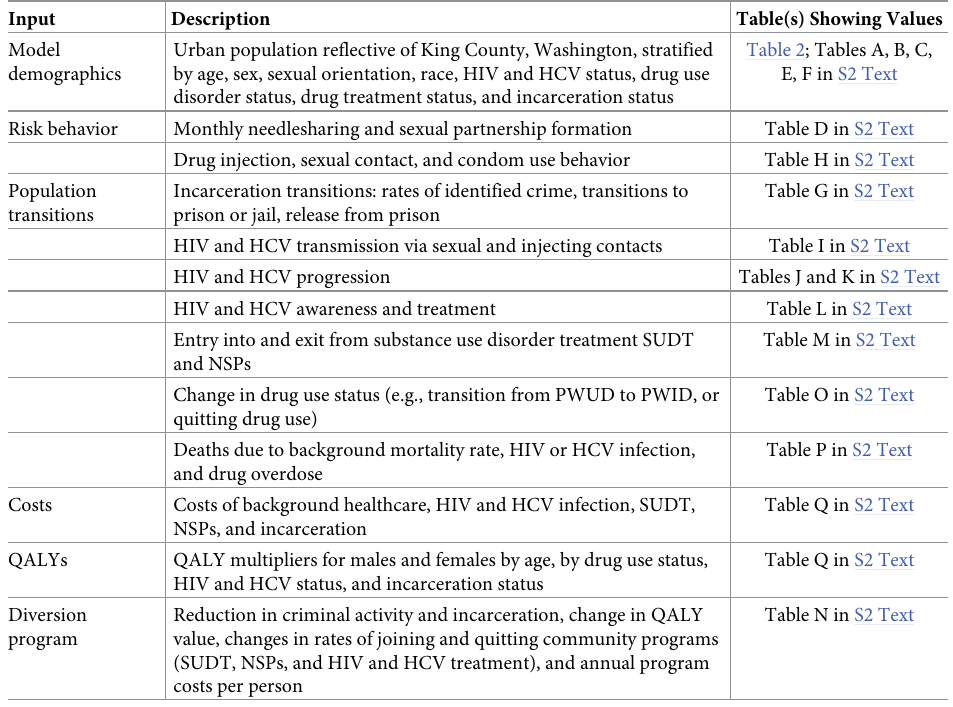
Table 1. Overview of key model